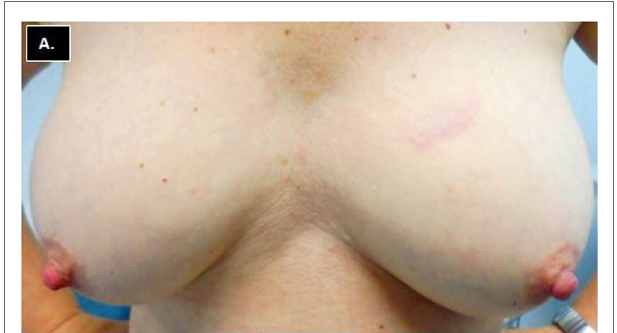
FigUre 3 | Frontal view of bilateral breasts showing excellent breast cosmesis 18 months following cyberKnife saPBi . SAPBI, Stereotactic accelerated partial breast irradiation.